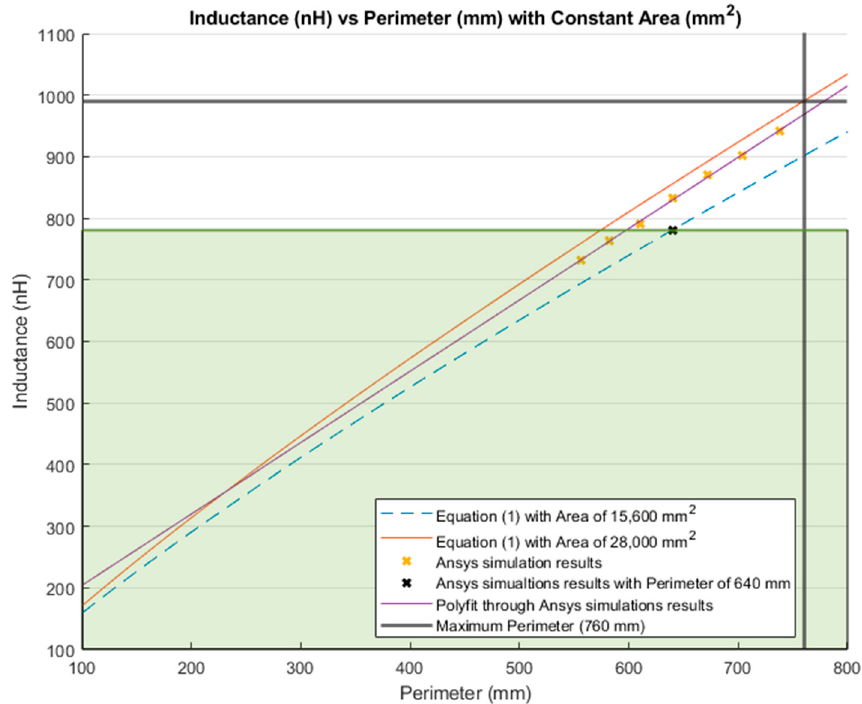
Figure 21. Inductance calculation with a constant area (mm 2 ) and a variable perimeter (mm). Highlighted in green shading is 78.81% of the total inductance change.